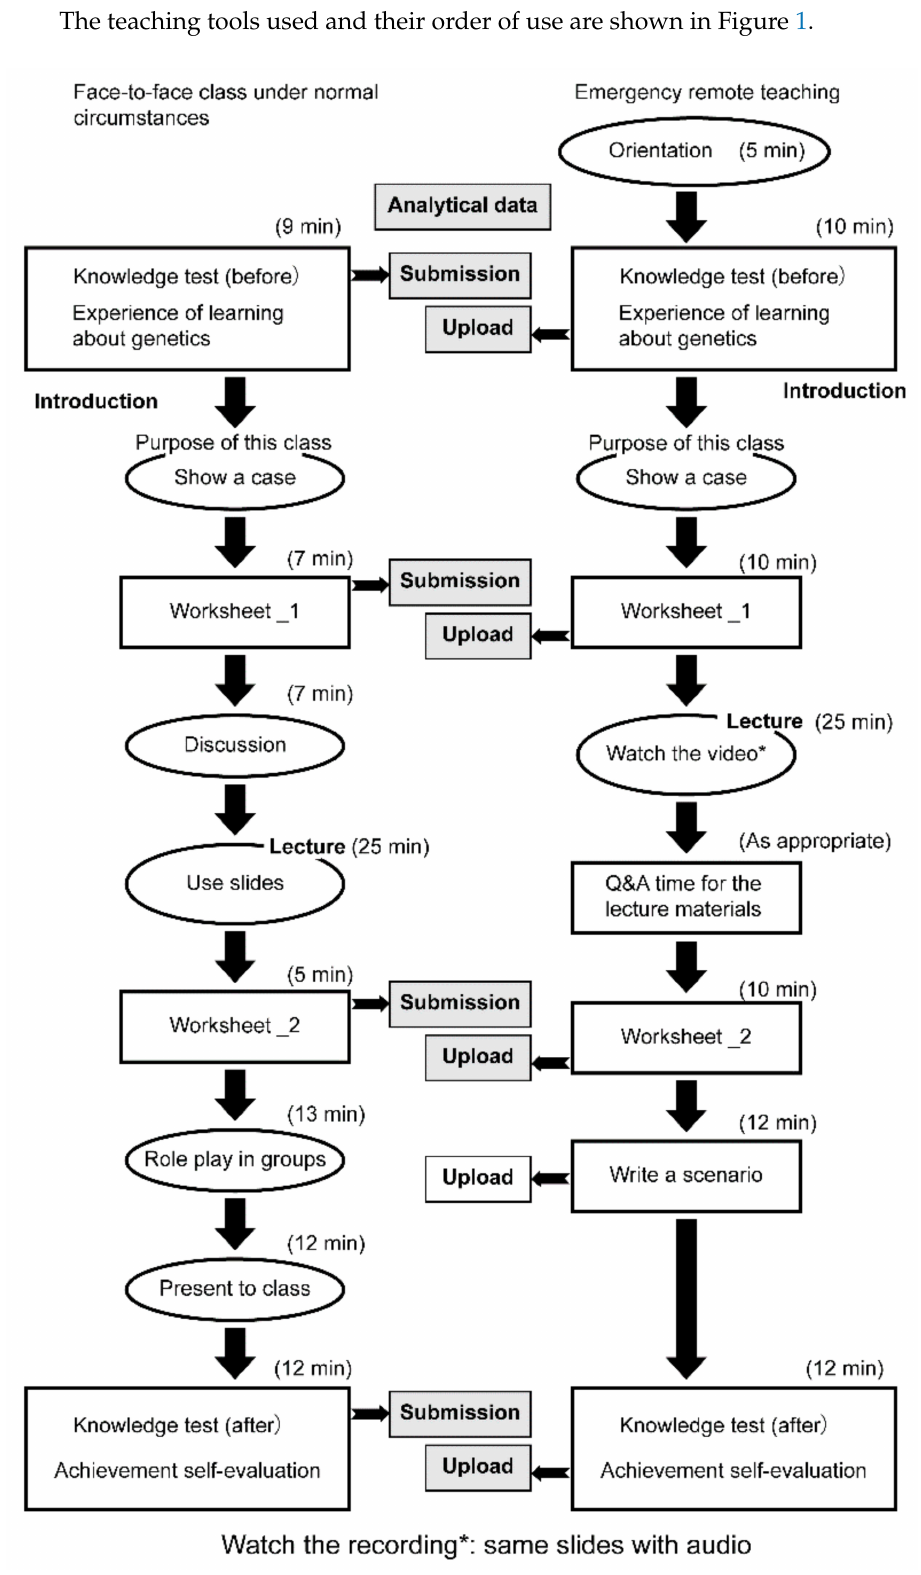
Figure 1. Teaching tools in order of use. * same slide with